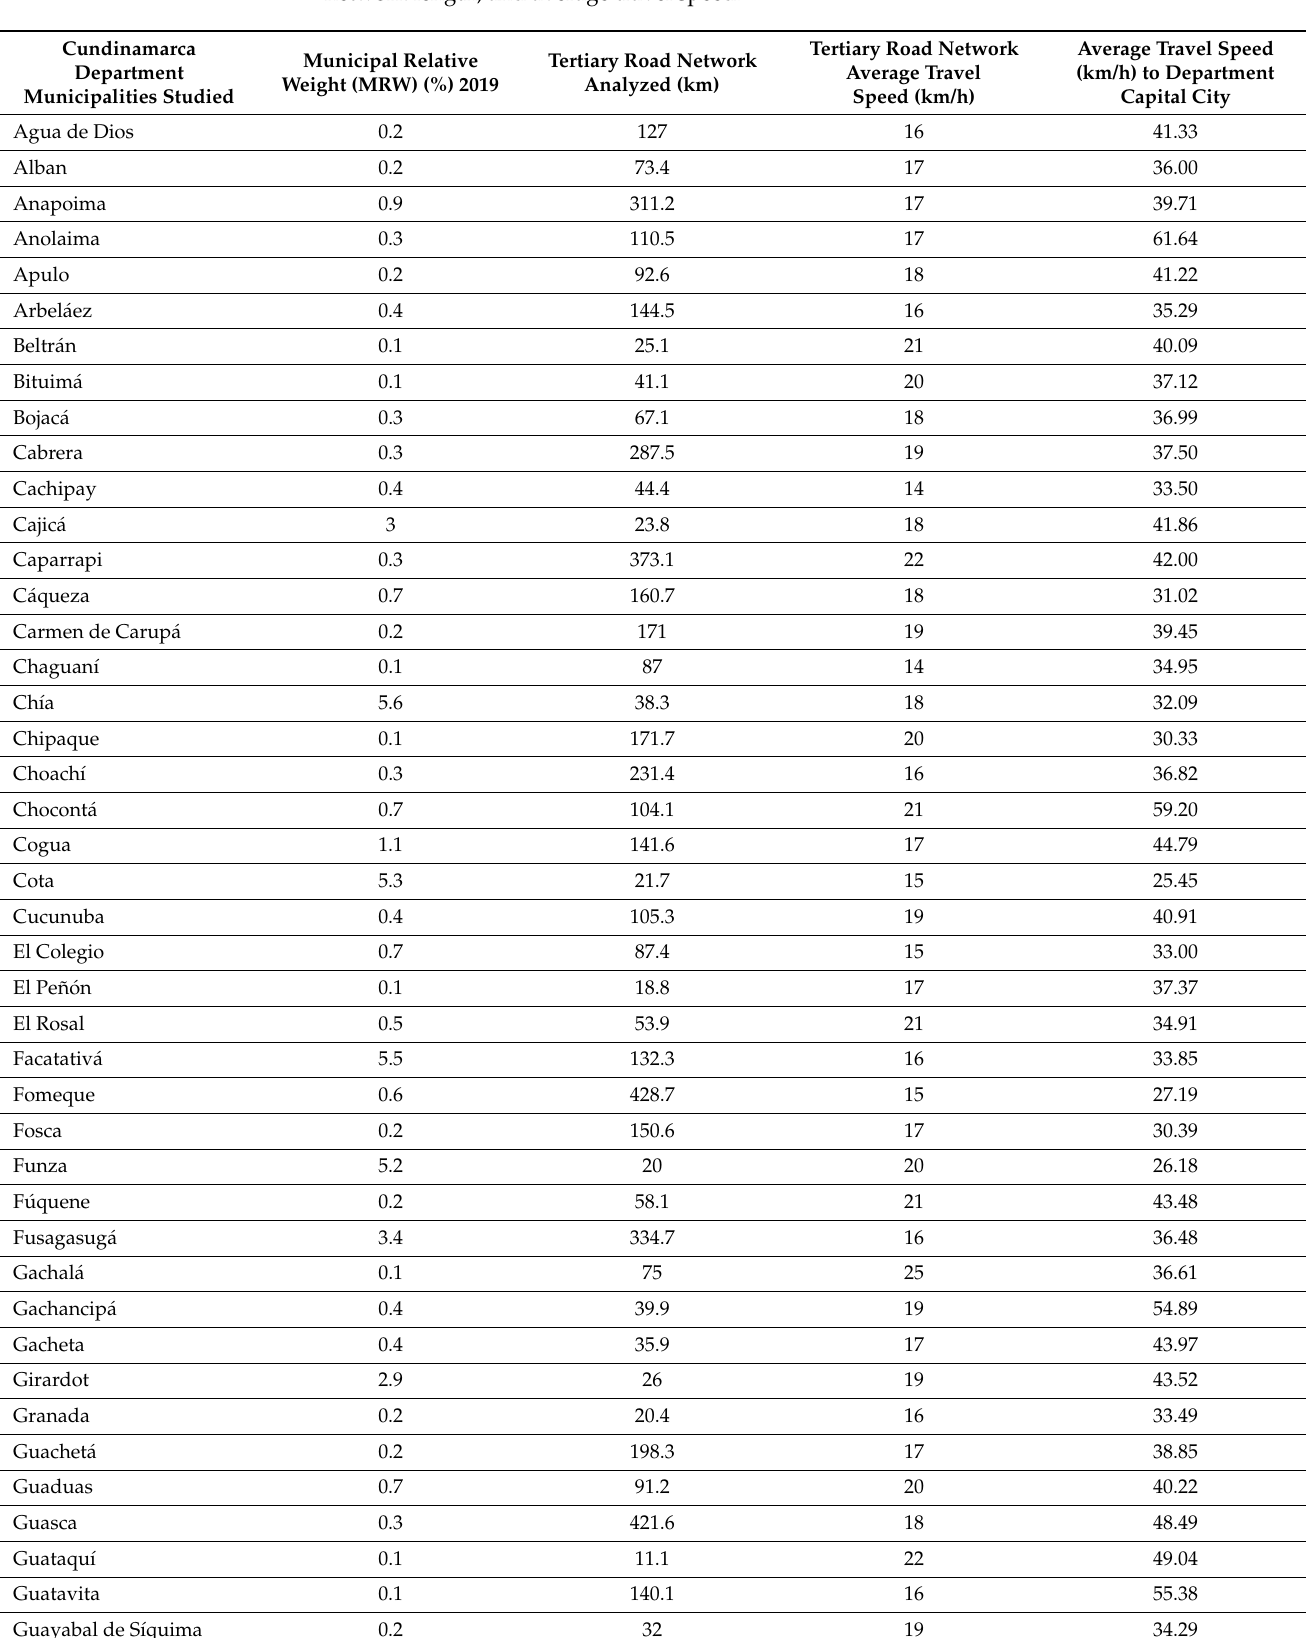
Table A2. Cundinamarca department municipalities studied information: MRW, tertiary road network length, and average travel